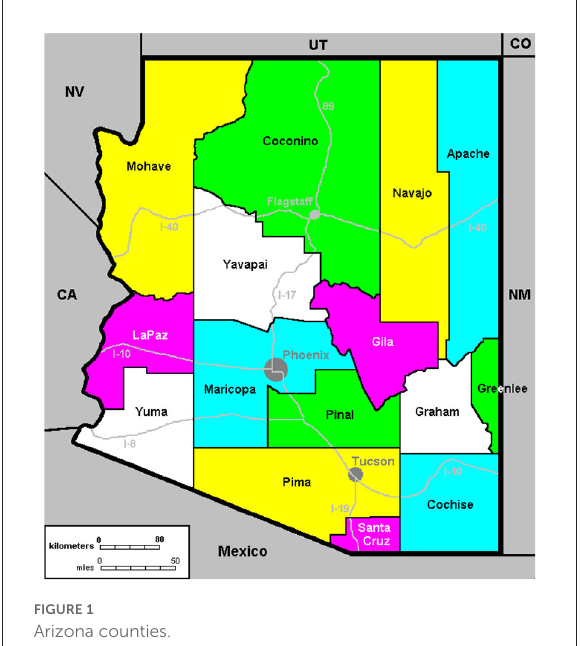
FIGURE1 Arizona counties.